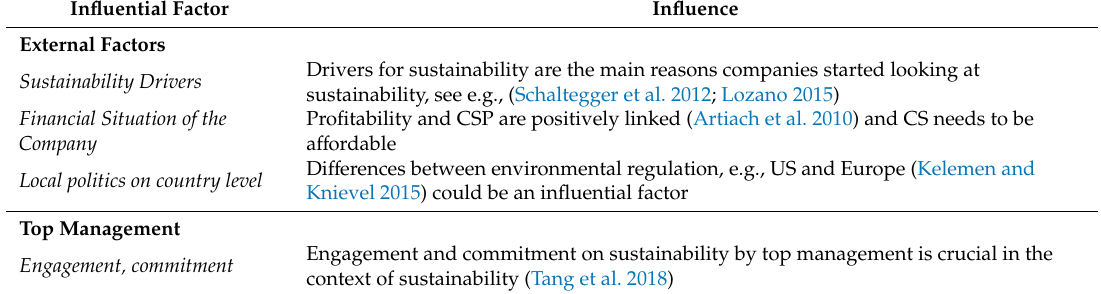
Table 1. Summary of influential factors on CS in